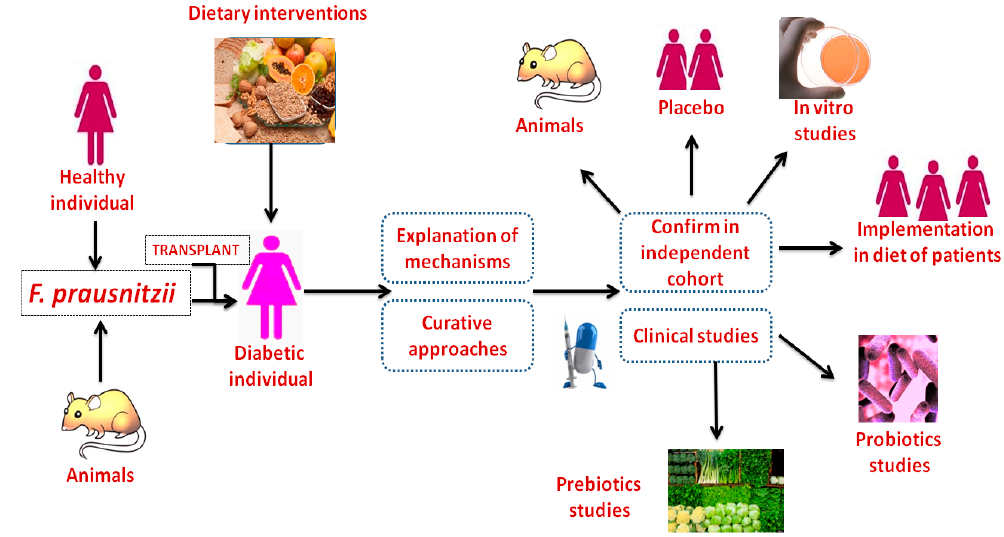
Figure 5. Novel strategies for diabetes prevention by dietary intervention and a transplant of